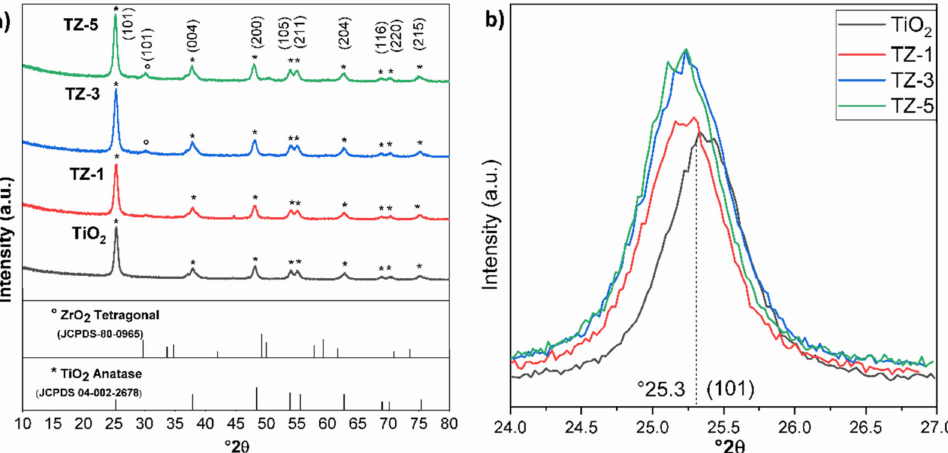
Figure 1. XRD patterns of the nanocomposite samples. ( a ) shows the different ZrO 2 contents, and ( b ) shows the amplification of the strongest reflection at 2 θ = 25.3 ◦ .